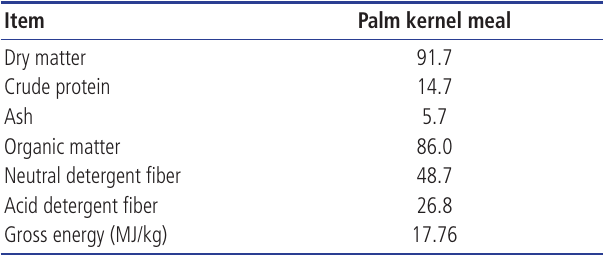
Table 1. Analyzed chemical composition of palm kernel meal (%, as-fed basis) 1)